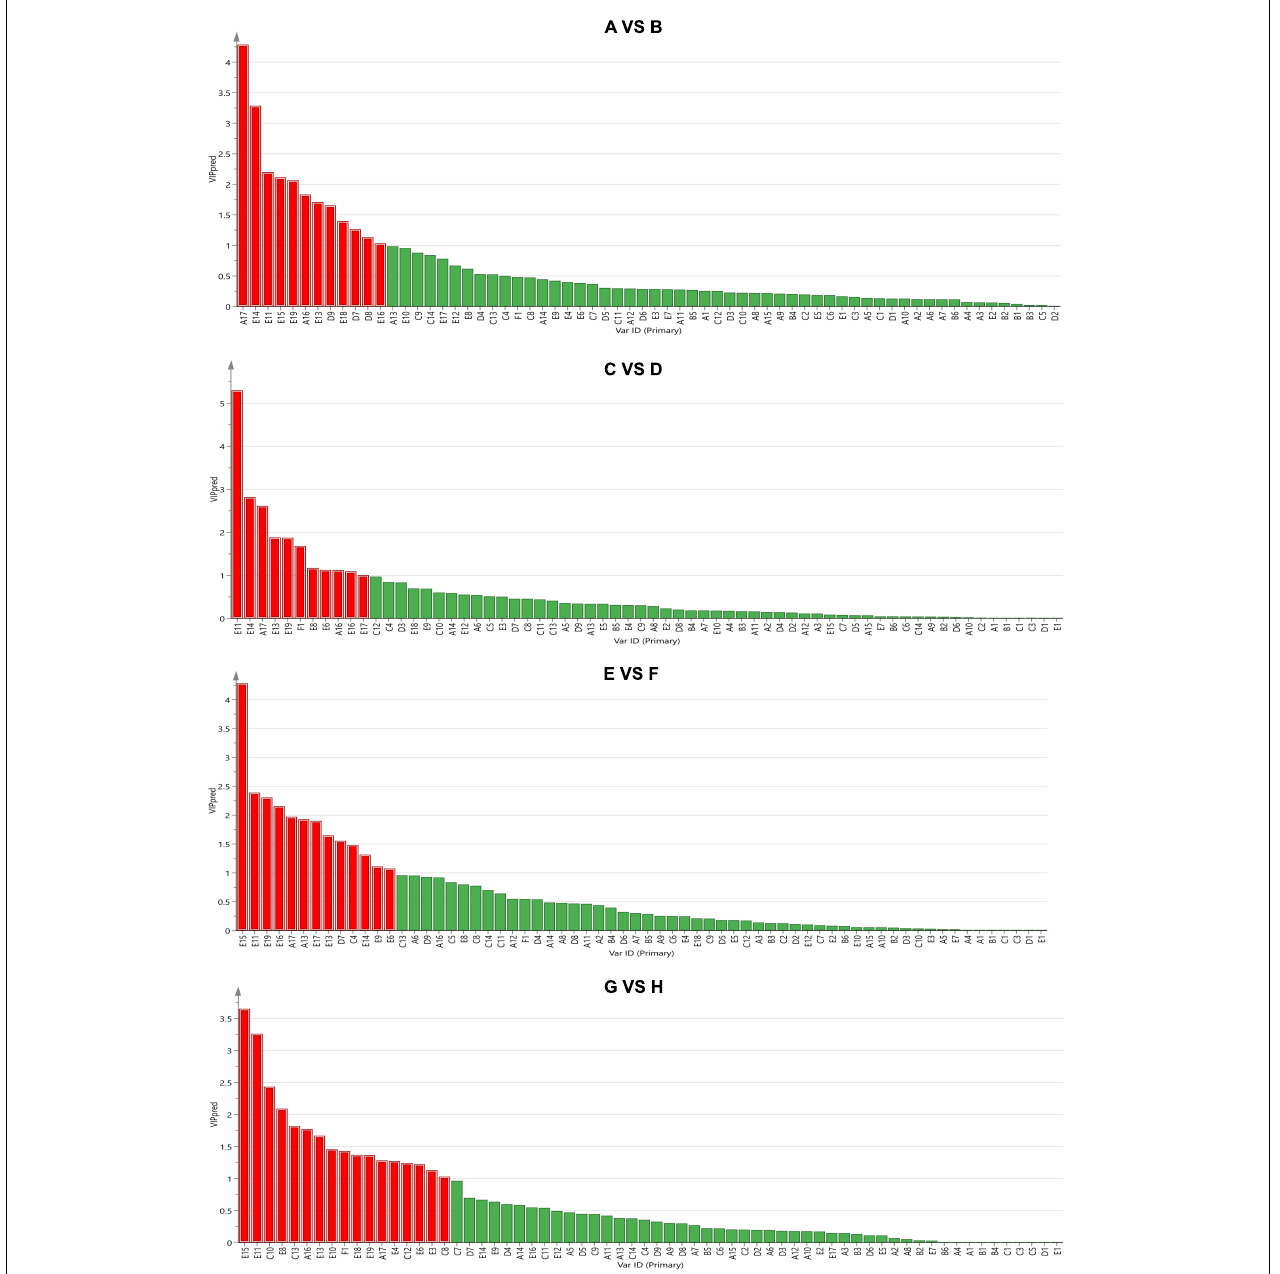
FIGURE 7 | The importance of variables in the projection (VIP = 6. VIP > 1 indicates extreme importance). The comparison between group A and group B, group C and group D, group E and group F, group G and group H from top to bottom. CS, CSM, CSS, CSM:CSS 1:1, CSM:CSS 1:2 and CSM:CSS 2:1 indicate the use of the commercial starter (Control group), K. marxianus B13–5, S. cerevisiae DL6–20, K. marxianus B13–5: S. cerevisiae DL6–20 1:1, K. marxianus B13–5: S. cerevisiae DL6–20 1: 2, and K. marxianus B13–5: S. cerevisiae DL6–20 2:1. (A1. 2-Furanmethanol; A2. 1-nonanol; A3. 1-Octanol; A4. 2,3-Butanediol;